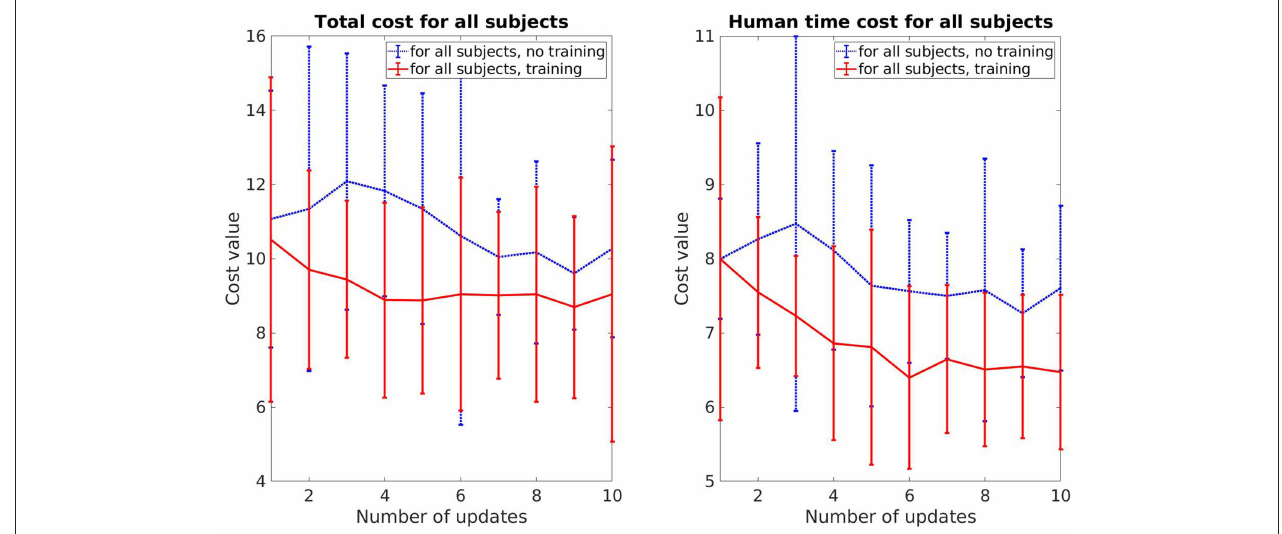
FIGURE 9 | Cost plots that show the difference between the control group that interacted with the untrained robot and the results for the interaction with the trained robot.